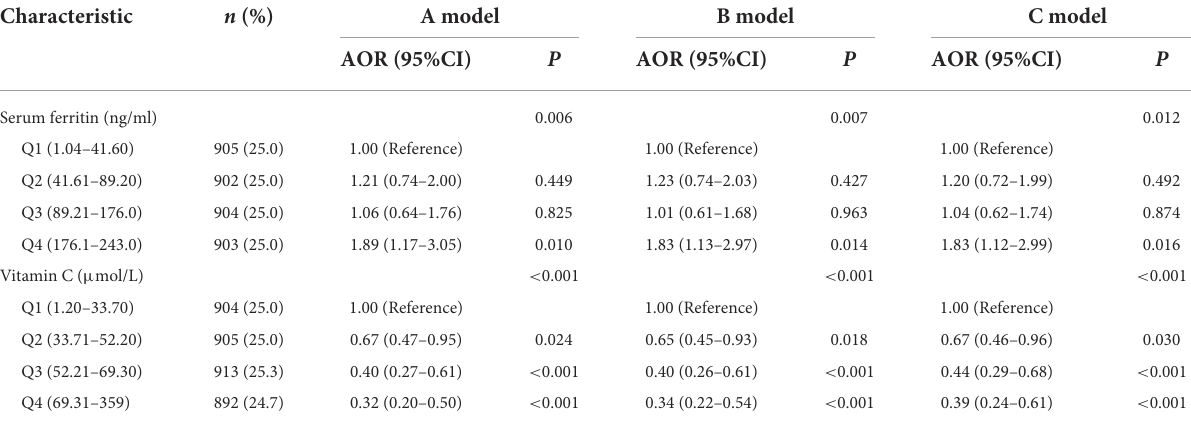
TABLE 4 Adjusted odds ratios of the association between the serum ferritin, Vitamin C, and hepatic fibrosis (F3–F4) in NHANES a . Characteristic n (%) A model B model C model AOR (95%CI)